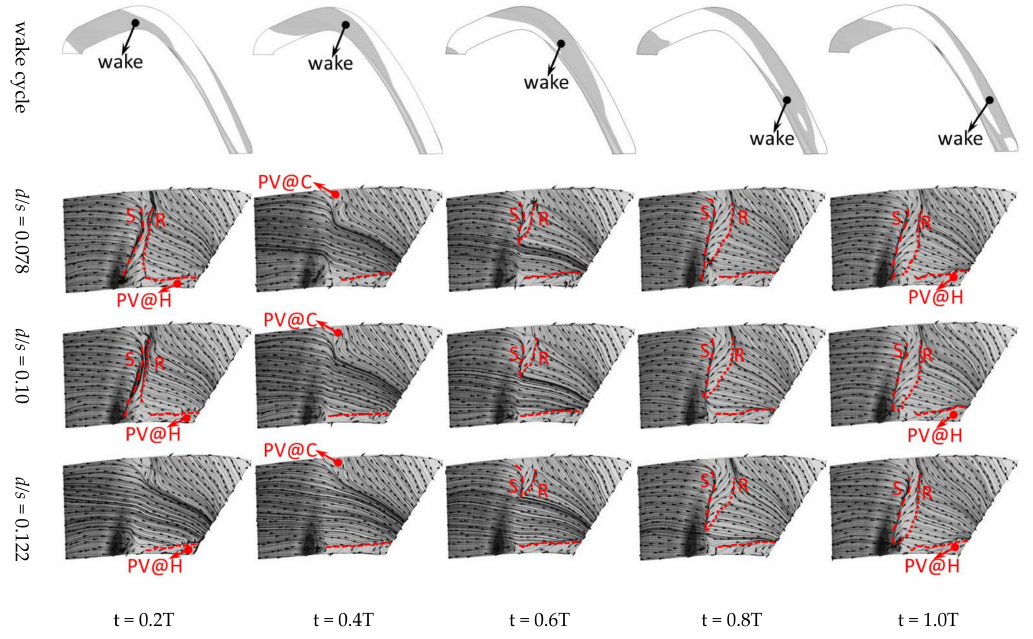
Figure 13. Limited streamline and static pressure coefficient contour on the suction surface of the integrated